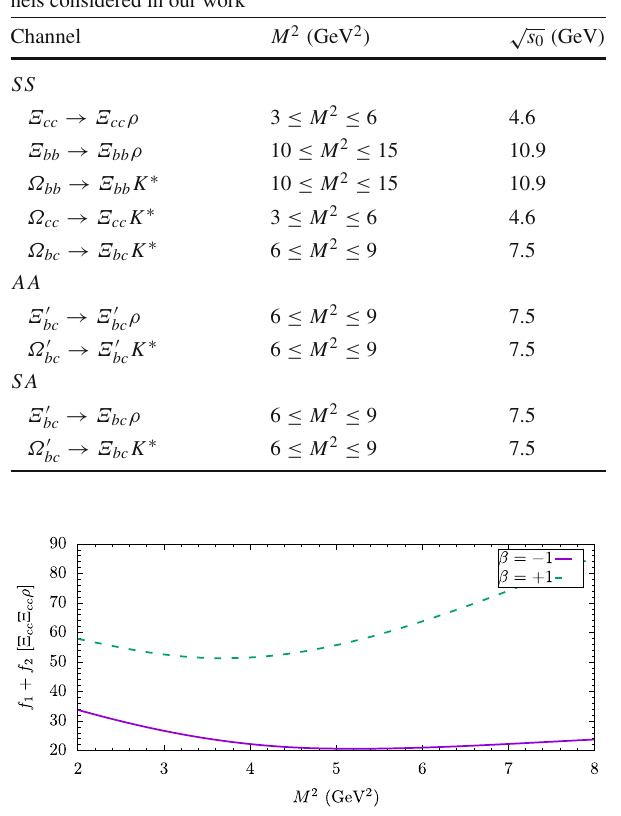
Ξ (cid:7) ρ √ bc bc s 0 = 7 . 5 GeV